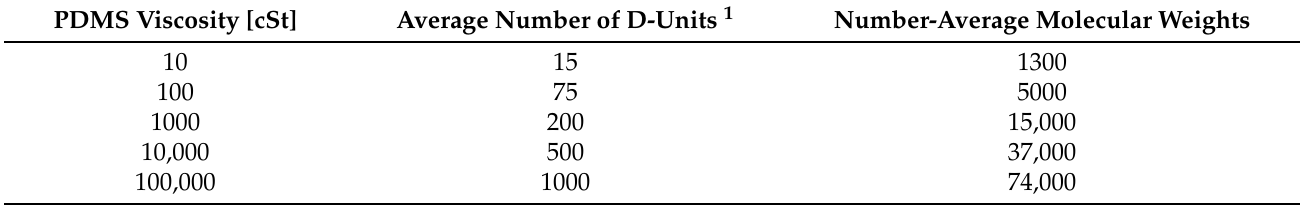
Table 1. Relationship between PDMS viscosity and molecular weight